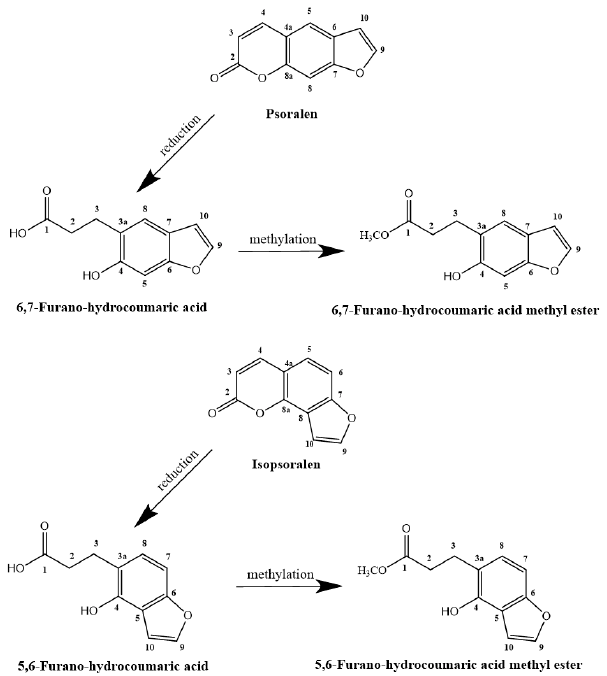
Figure 2. The possible metabolic pathways of P and IP by human intestinal bacteria.